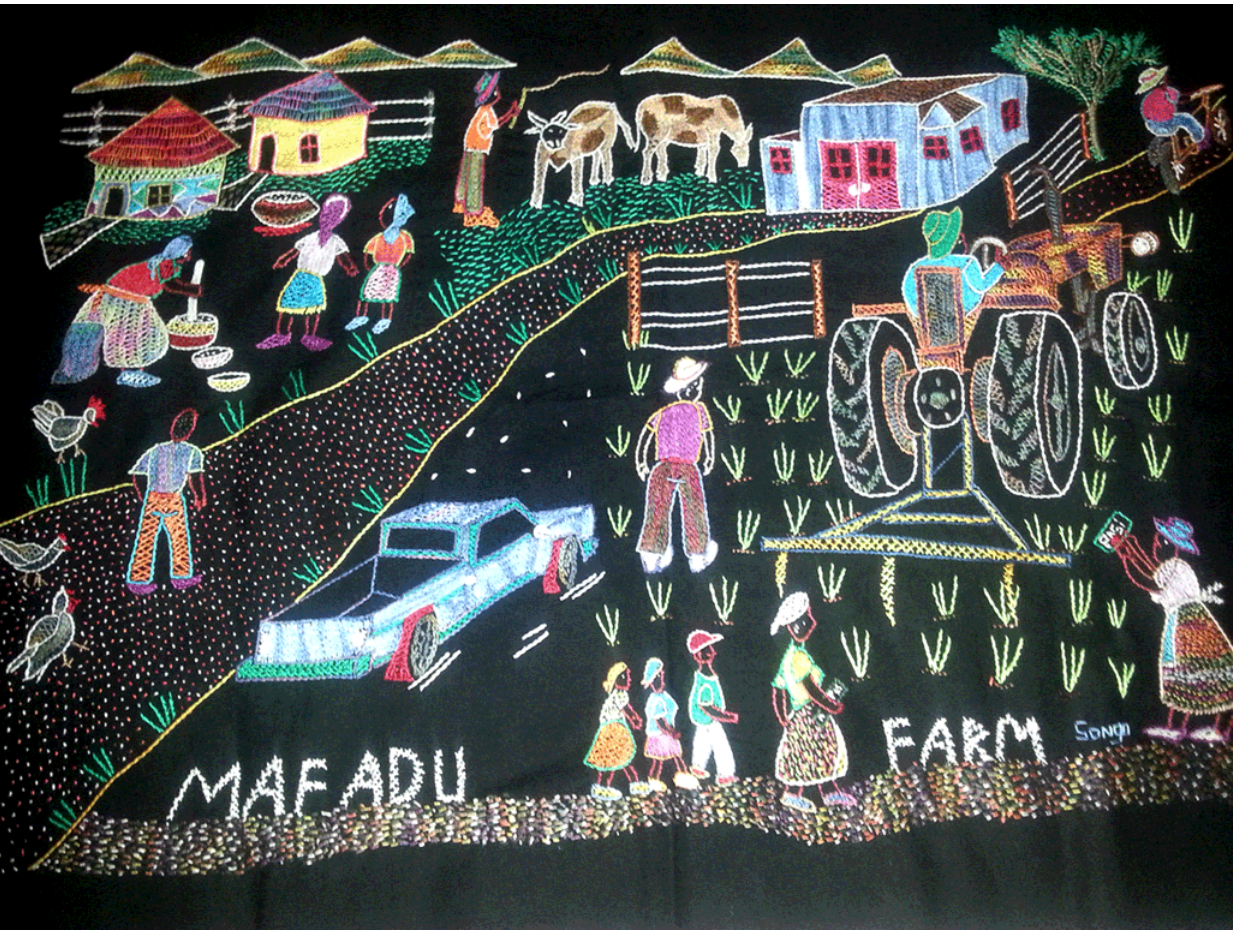
Figure 2. Tselane’s